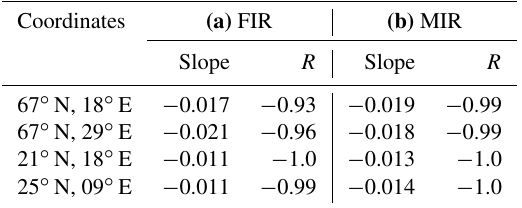
Table C1. Complementary table to Fig. C1a and b. A linear slope is fitted to the values for each scene using a least squares minimiza- tion, and as the intersect of all the fits is 0, only the slopes are quoted here. The sample Pearson correlation coefficient ( R ; see Eq. C1) is also calculated for each set of points. The corresponding p value (hypothesis test) for all eight cases is smaller than 10 − 12